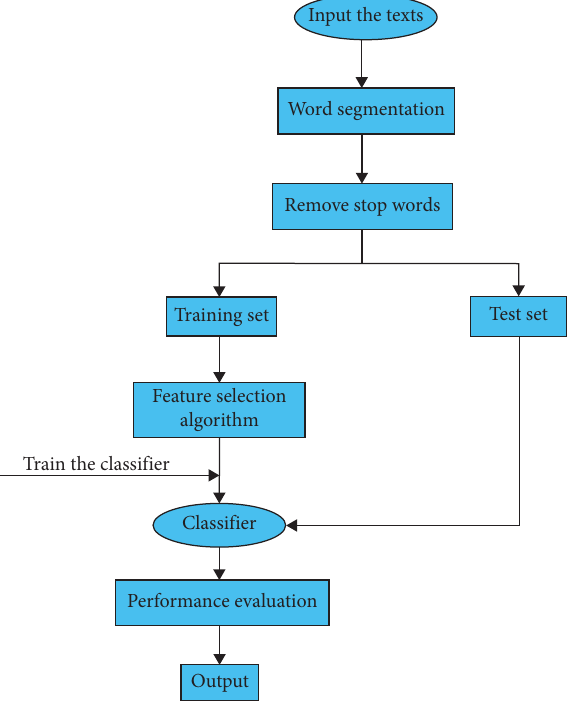
Figure 1: The process of feature selection in text classification. Table 4: Comparison of classification results between CHI and Var-CV-CHI on the balanced Chinese corpus (KNN).